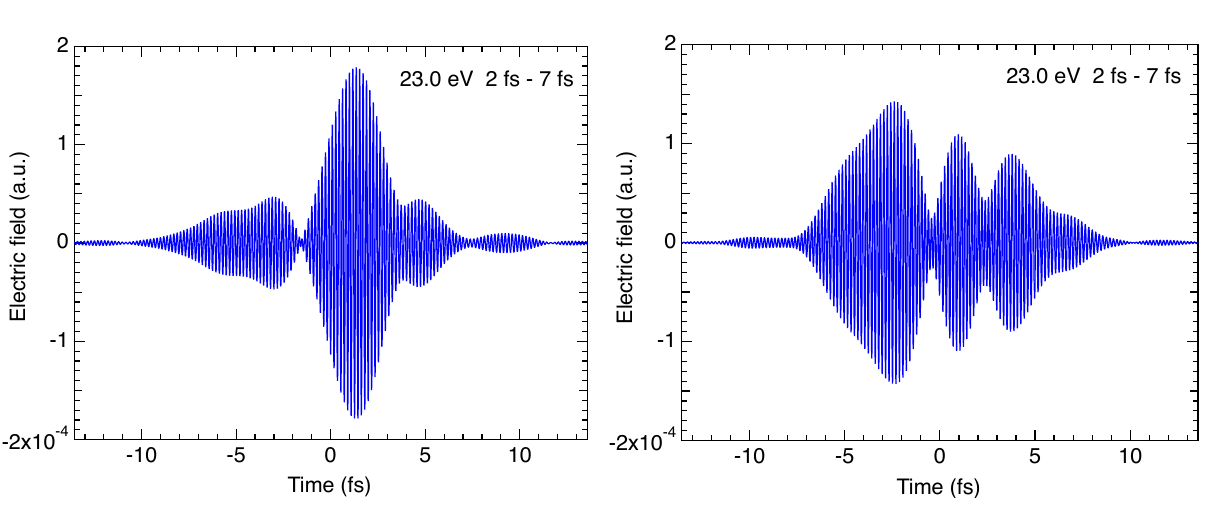
Figure 8. Typical pulse shapes generated by the partial-coherence method [81] for the case of 23.0 eV photon energy, 2 fs coherence time, and 7 fs mean pulse